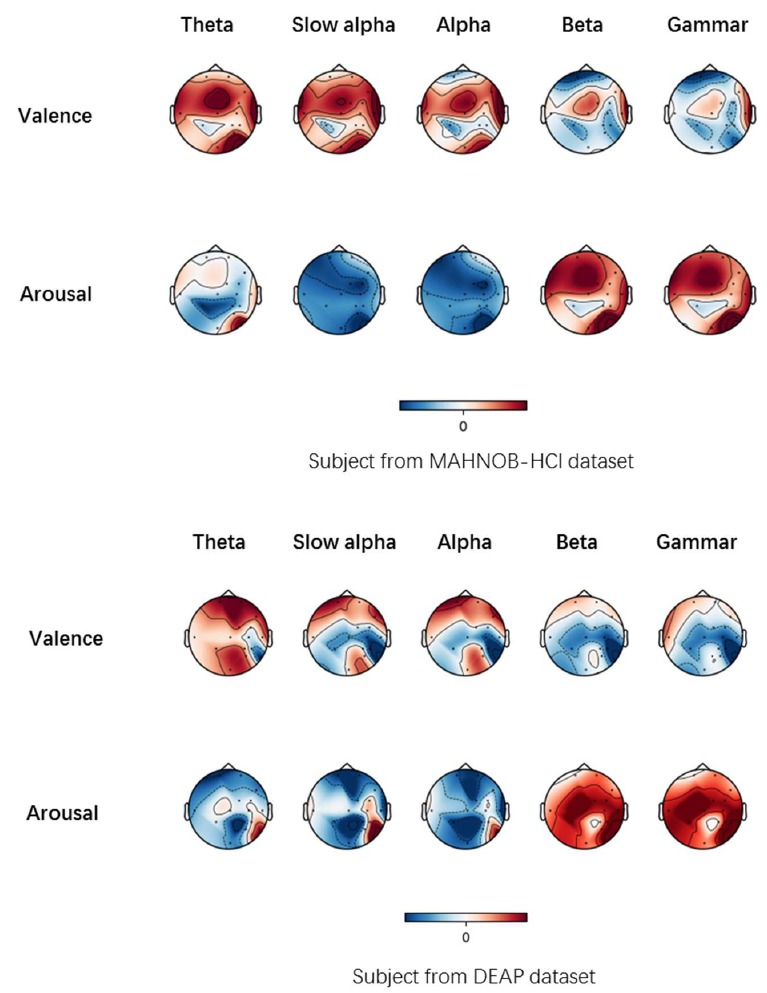
Figure 5. The correlation maps between PSD and continuous valence for theta, slow alpha, alpha, beta, and gamma bands. The correlation values are averaged over all sequences.